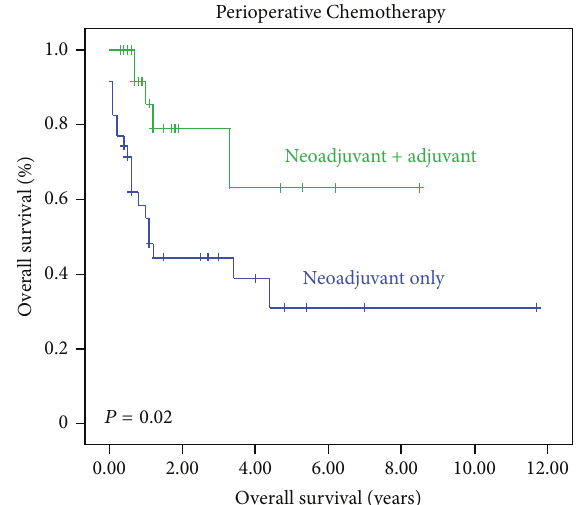
Figure 1: The overall survival comparing patients who com- pleted both neoadjuvant and adjuvant chemotherapy courses versus patient who received only neoadjuvant